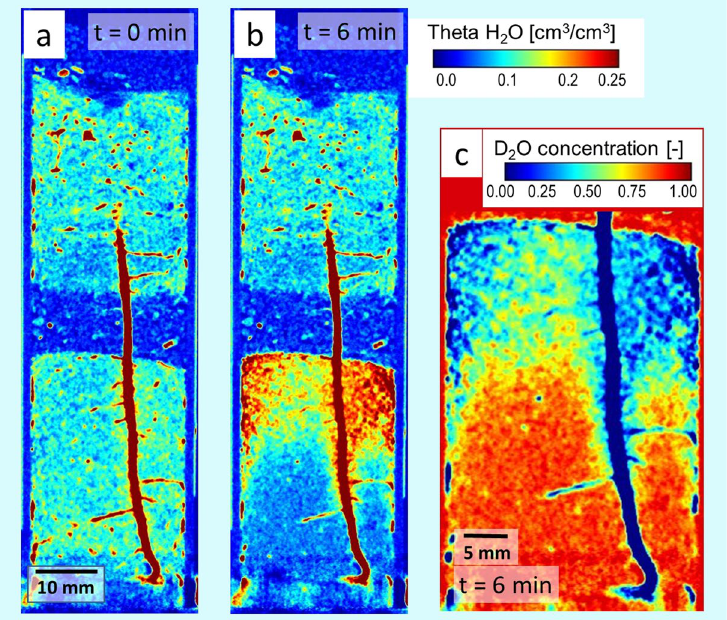
Figure 2. 2D vertical cross section of the plant sample “M 14” taken at the position of the primary root during the experiment at daytime. ( a ) Distribution of the volumetric soil water (H 2 O) content before injection. The overall soil water content is θ H2O = 0.10 cm 3 /cm 3 . ( b ) Distribution of the volumetric soil water (H 2 O) content after injection of 4 ml D 2 O. The total water (H 2 O + D 2 O) content in the lower soil compartment increased to θ liquid = 0.27 cm 3 /cm 3 . Note that the colour scale was adapted to resolve the range of soil moisture and the calibration used does not apply to the roots. ( c ) Local D 2 O concentration of the soil water solution in the bottom compartment calculated under the assumption of a uniform total soil moisture of θ liquid = 0.27 cm 3 /cm 3